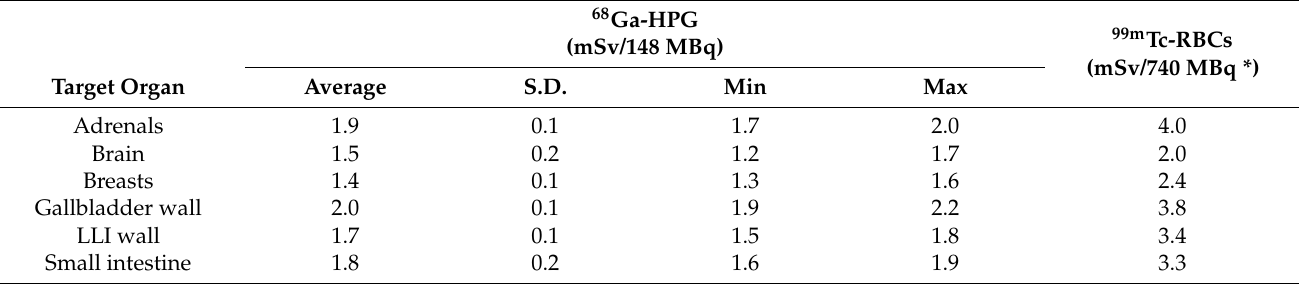
Table 3. Comparison of the radiation dosimetry of the new blood pool agent 68 Ga-HPG and conventional 99m Tc-labeled RBCs (from Stabin et al. [43]), using the average * recommended imaging dose. 68